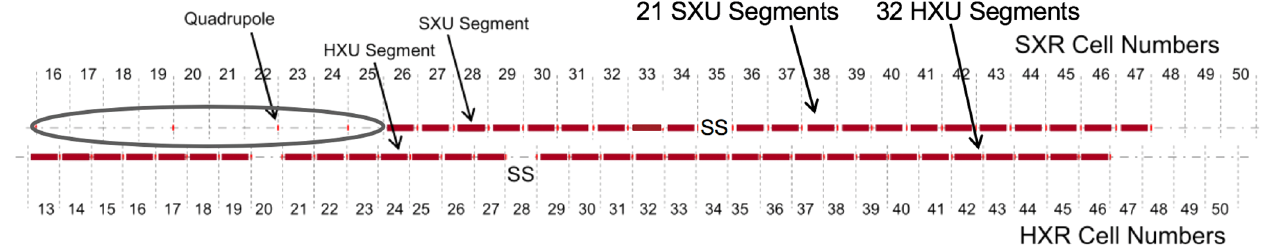
FIG. 1. Layout of the LCLS-II soft x-ray (top) and hard x-ray (bottom) undulators. Both undulator lines will be fed by the 1 MHz e-beam, which goes left to right. The SXR line is composed of 21 undulators segments each 3.4 m in length, occupying a total footprint of 96 m. General e-beam and undulator properties are given in Tables I and II. There is about 40 m of space available upstream of the SXR line (circled) that could be used for external seeding infrastructure. Slot 35 (undulator no. 10) will accommodate the SXRSS system.